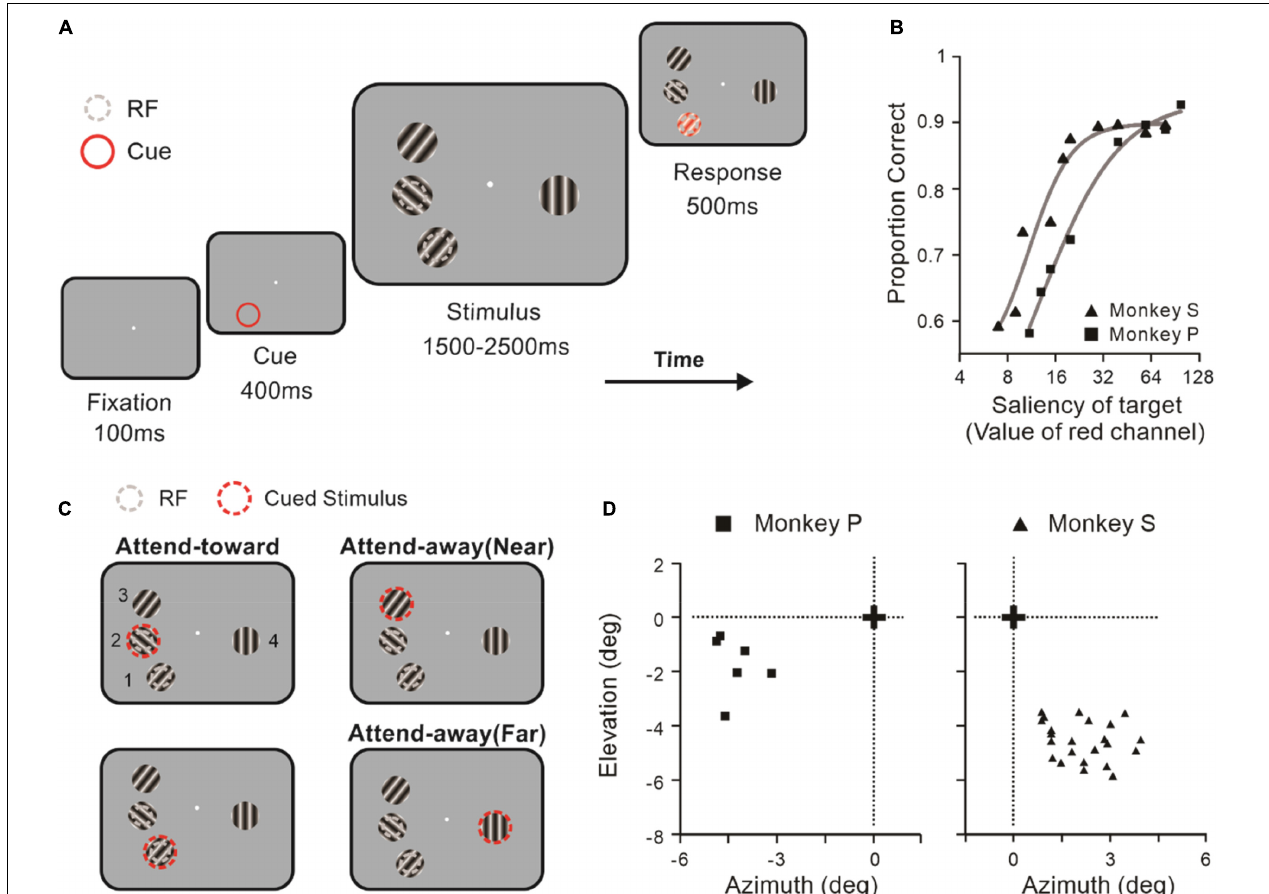
FIGURE 1 | Behavioral task and results. (A) The paradigm of the color-change detection task. After monkeys fixated on the white spot for 100 ms, a red ring appeared for 400 ms as a cue for attentional focus. Then four sinusoidal drifting gratings with identical eccentricity were presented at different locations for a uniformly randomized period (1,500–2,500 ms). The monkey was rewarded for the successful saccade to the grating at the cued location within 500 ms after the color of the grating trough changed to red. (B) Performance curves of two monkeys across sessions. Individual points represent the averaged detection accuracy at a given value of redness (monkey P: square; monkey S: triangle). Solid lines represent fits of logistical function to the data. (C) Illustration of attentional conditions. Two non-overlapped stimuli cover the RFs of the recorded neuronal pairs independently. The dashed red rings indicate the cued stimuli. The condition is defined as an attend-toward (AT) condition when the cued stimuli overlap one of the recoded neurons’ RFs. The cued stimulus appears on the ipsilateral side of neurons’ RFs in the attend-away near (AAN) condition, while it presents on the contralateral side in the attend-away far (AAF) condition. (D) The location of RF centers (monkey P: square; monkey S: triangle) of recorded neurons and the fixation point (black